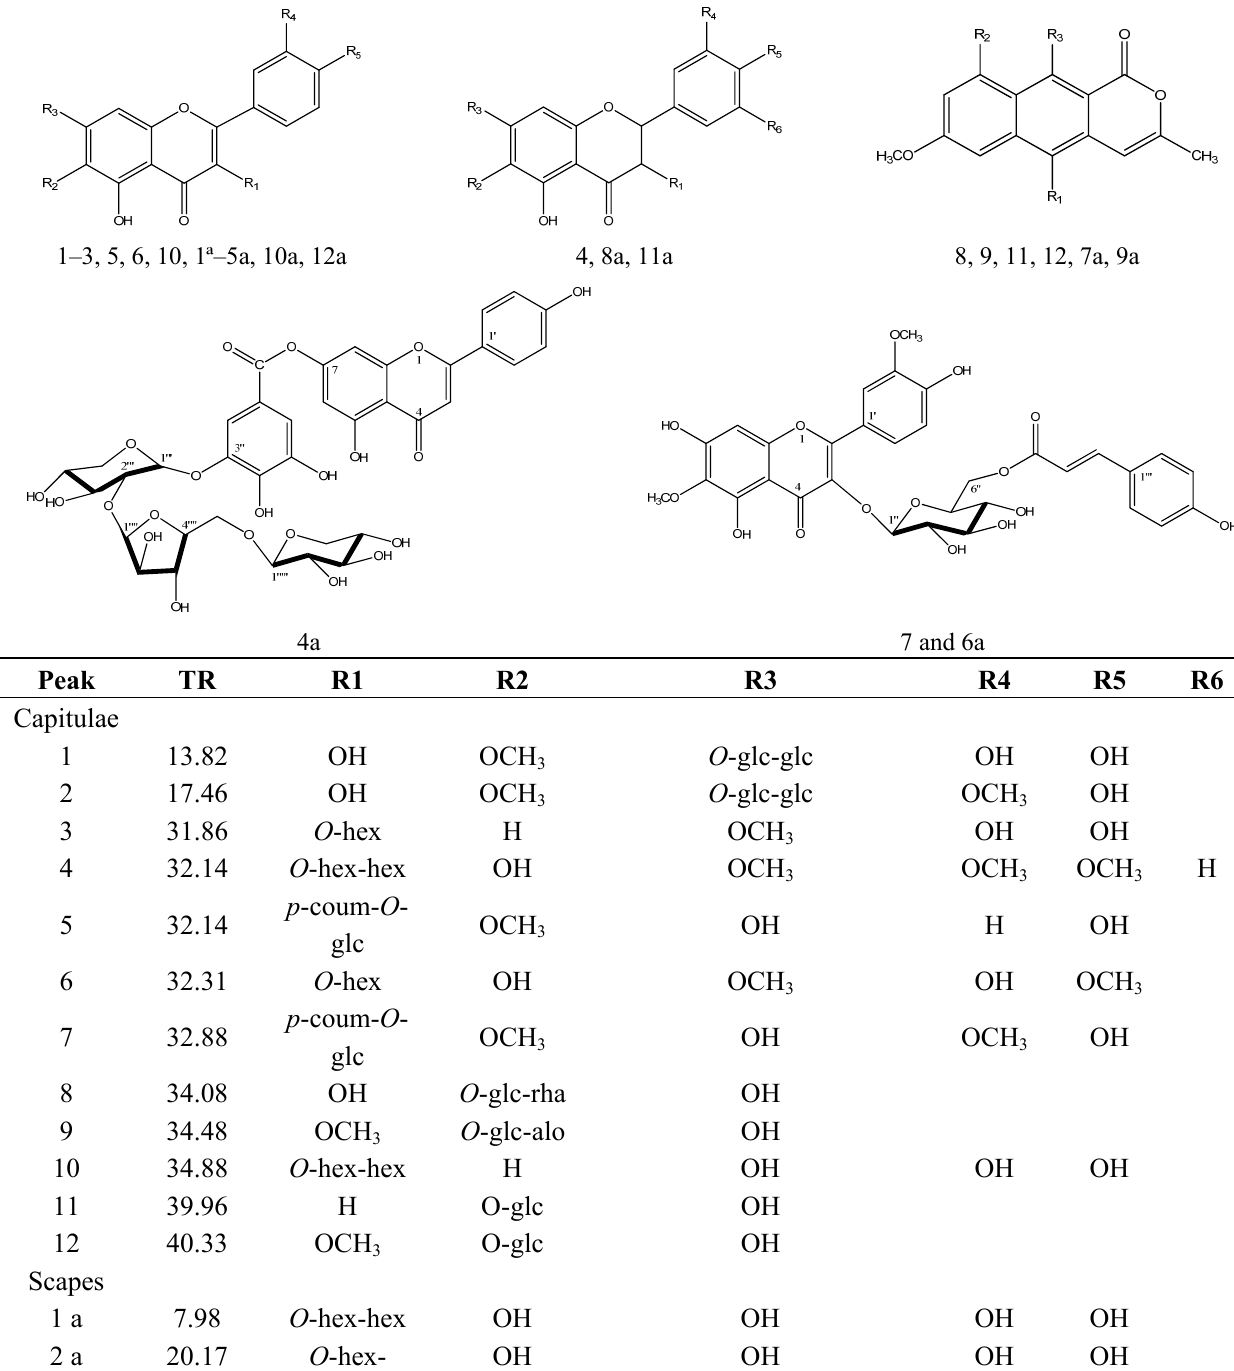
Figure 3. Structure of the compounds identified in the capitulae and scapes from P.